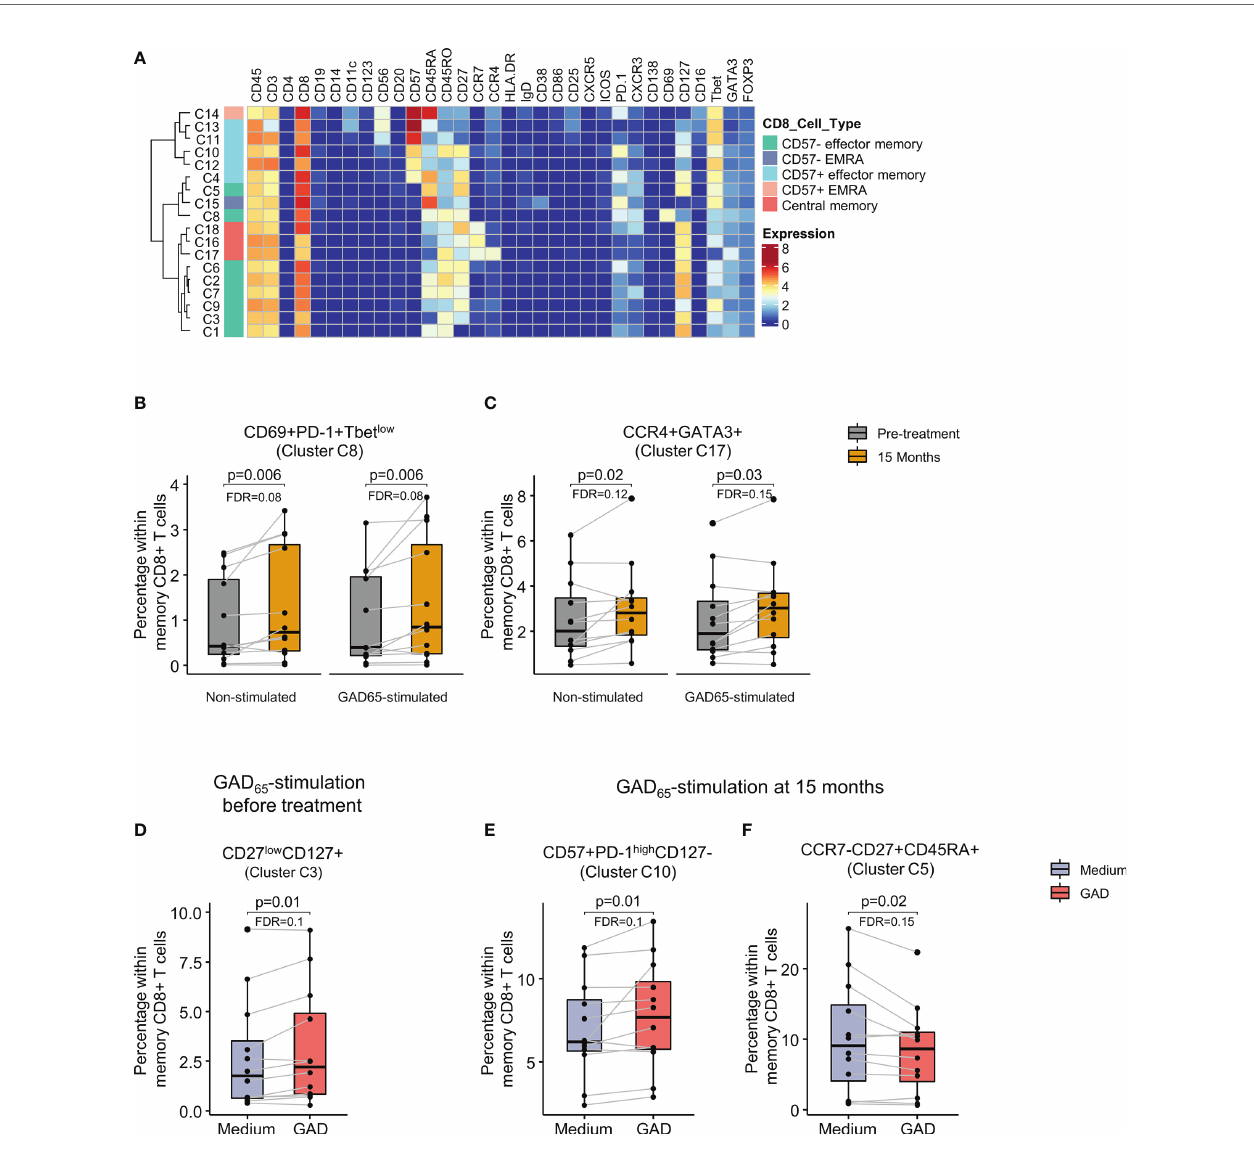
FIGURE 5 | Identi fi cation of memory CD8+ T cell clusters and changes after GAD-alum therapy. (A) Heatmap showing median marker expression across the 18 clusters identi fi ed within memory CD8+ T cells. Proportion of (B) CD69+PD-1+Tbet low cells (cluster C8) and (C) CCR4+GATA3+ cells (cluster C17) within memory CD8+ T cells before (grey) and after treatment (yellow) in non-stimulated and GAD65-stimulated samples. (D) Proportion of CD27 low CD127+ memory CD8 + T cells (cluster C3) in PBMCs collected before treatment and cultured in medium alone or in the presence of 5 m g/ml of GAD 65 for 72 hours, and proportion of (E) CD57 +PD-1 high CD127- (cluster C10) and (F) CCR7-CD27+CD45RA+ (cluster C5) memory CD8+ T cells in PBMCs collected after 15 months of treatment and cultured in medium alone or in the presence of 5 m g/ml of GAD 65 for 72 hours. Dots represent individuals and boxplots indicate median and interquartile range. Wilcoxon signed-rank test. p < 0.05 was considered signi fi cant. FDR, False discovery rate (Benjamini –